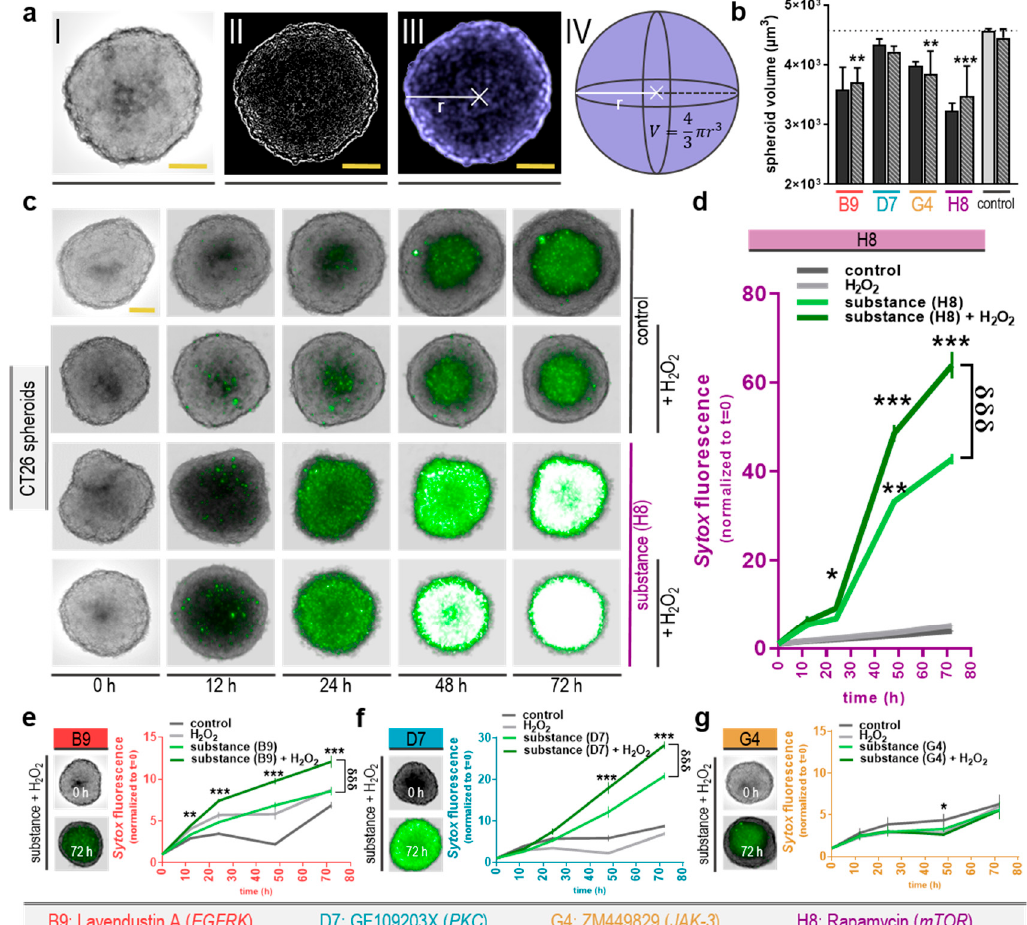
Figure 4. Toxicity of selected kinase inhibitors with H 2 O 2 in 3D tumor cell spheroids of CT26 colorectal cancer cells. ( a ) Representative high-content image analysis strategy of 3D cancer spheroids shaped from initially 3 × 10 3 cells shown as i) brightfield image (scale bar = 300 µ m), ii) processed high contrasted image, with iii) detected spheroid area and iv) the volume calculation approach; ( b ) calculated spheroid volume + SEM 72 h post-incubation with selected kinase inhibitors ( +/ − H 2 O 2 ); ( c ) representative maximum projection intensity images from 16 z-stacks in brightfield and Sytox Green fluorescence channel imaged over a 72 h time-course (scale bar = 300 µ m) under incubation with the substance H8 under various conditions; ( d ) quantification of the Sytox mean fluorescence intensity + SEM inside the spheroid region during this time-course; representative images of selected kinase inhibitors with H 2 O 2 at t = 0 and t = 72 h; ( e ) the quantification for the substances B9, ( f ) D7, and ( g ) G4 + SEM. Significance levels for the comparison of substances without H 2 O 2 to the respective substances with H 2 O 2 ( δ ), and of their combination (with H 2 O 2 ) to the H 2 O 2 -alone control (*) were determined via ANOVA. Data are representatives out of three independent replicates. Table 2. Summary table of the key results identified in this study. Shown are the toxicity in 2D and 3D cultures with the combination treatment of the four in 2D cultures identified drugs, as well as cell